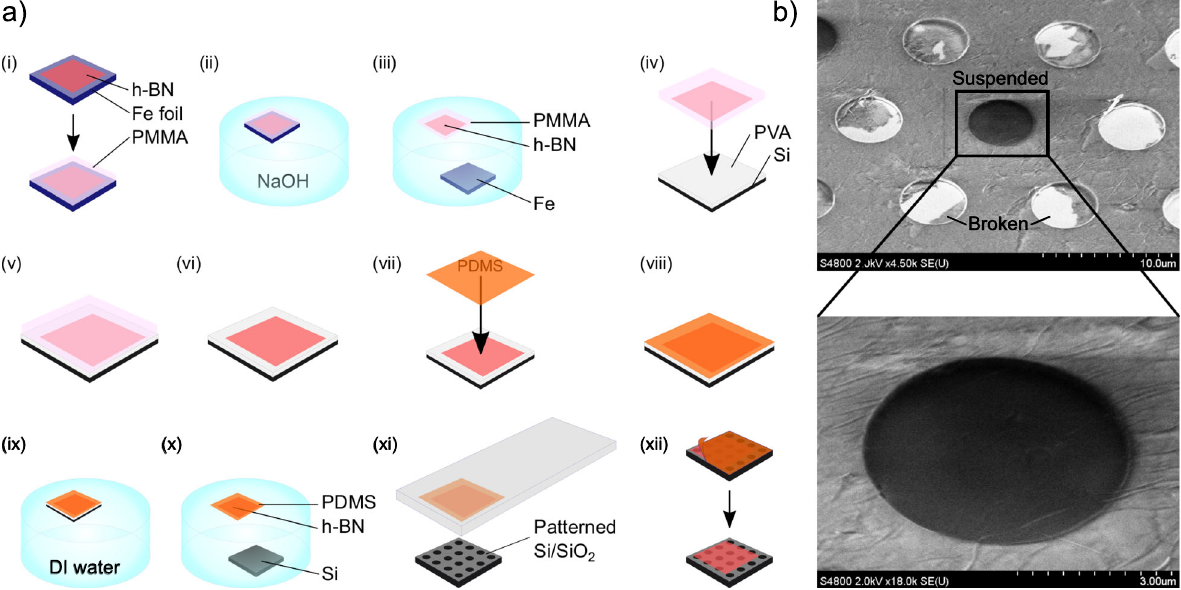
Fig. 1 CVD single-layer h-BN growth and dry transfer. a Large-area single-layer h-BN is grown by chemical vapor deposition (CVD) on Fe foils, and it is coated with PMMA (i). Then, the h-BN/PMMA stack is delaminated from the foil by means of bubbling 17 (ii, iii). The h-BN is transferred to a Si/PVA substrate, and the PMMA is removed with acetone (iv – vi). PDMS is placed on the Si/PVA/h-BN (viii), and the structure is left fl oating on DI water (ix). When the Si substrate detaches from the layer stack (x), the h-BN/PDMS is picked and dried. From this point, the usual viscoelastic dry transfer technique 33 is used to transfer the CVD single-layer h-BN on patterned substrates (xi-xii). b Scanning electron microscope image of CVD single-layer h-BN covering circular cavities of 5 µm in diameter ( top panel ). Since h-BN is an insulator, electrons are trapped in the suspended material and appear with high contrast. A fl at drum with a few wrinkles is shown in the bottom